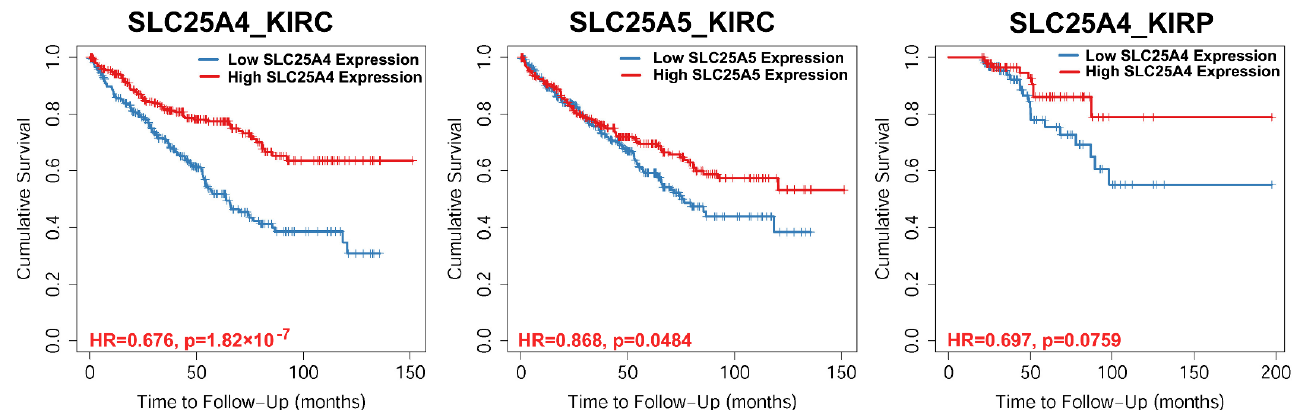
Figure 4. Survival analysis of TCGA kidney cancer patients as a function of the expression of the indicated AACs. Cumu- lative survival probability was evaluated in patients with the highest and lowest 50% gene expression using the Kaplan- Meier curve and Cox proportional hazard model as calculated by Timer2. Hazard ratio (HR) and the significance of the outcome (p) are also indicated.